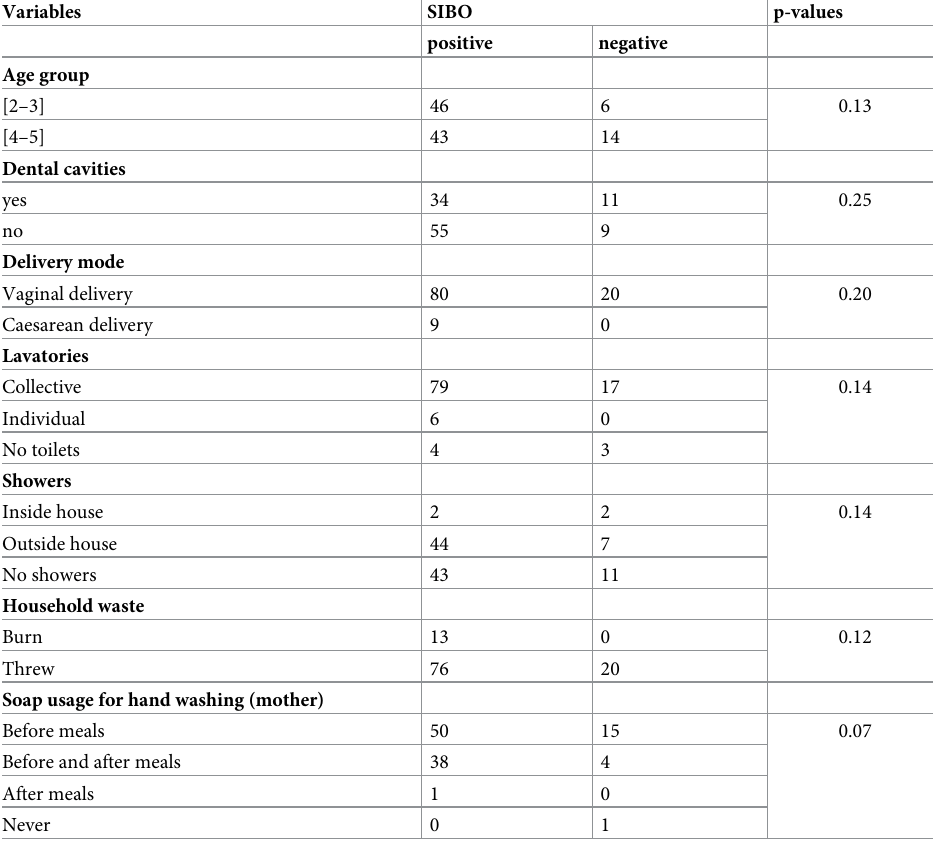
Table 3. Possible risk factors associated with SIBO. Only variables having a P-value � 0.25 in the univariate analysis (S2 Table) were entered into multivariate logistic regression for a final analysis (S3 Table). All variable were recorded by field workers (clinical research associates).